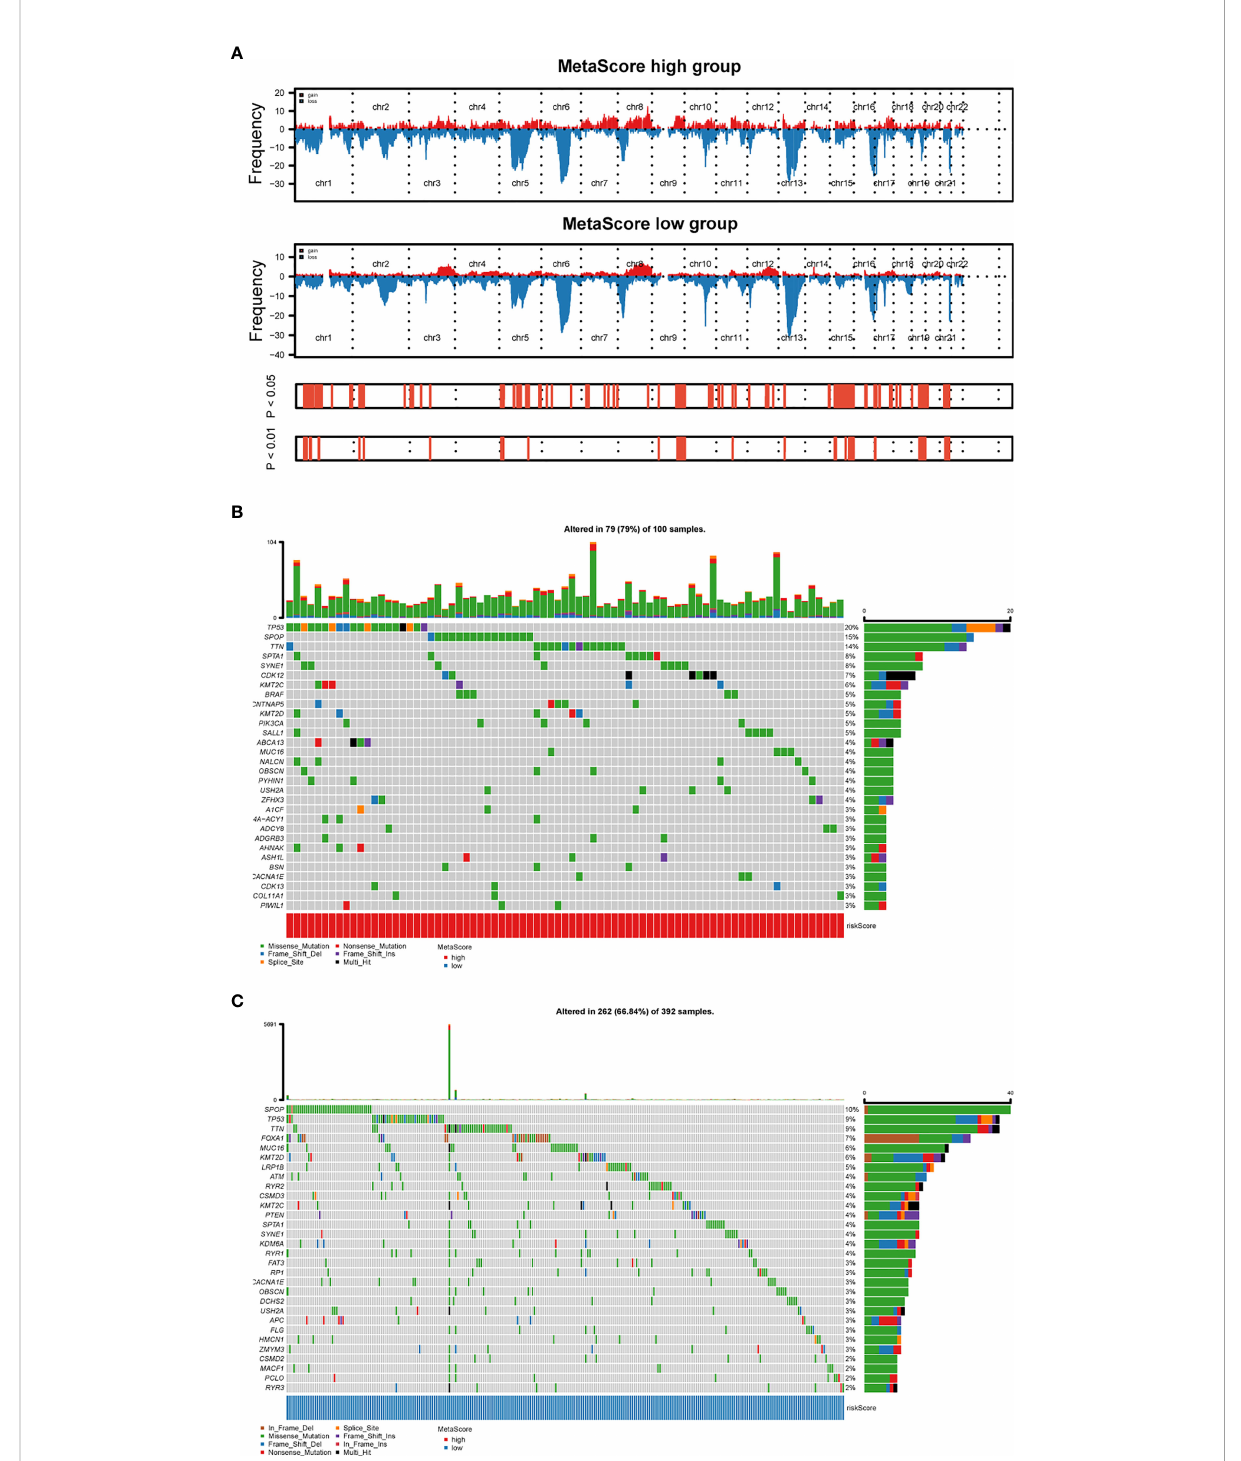
FIGURE 5 Distinct genomic pattern related to MetaScore. (A) Ampli fi cations and deletions in PCa with high- and low-MetaScore. Chromosomal regions of peaks correspond to the relevant recurring focal ampli fi cation (red) and deletions (blue). (B, C) The overall somatic mutation pro fi le with the highest frequency in high- and low-MetaScore groups. P< 0.05 indicates statistical signi fi